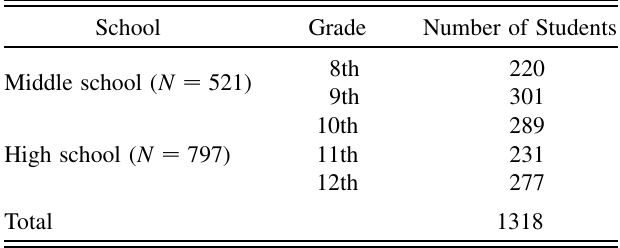
TABLE II. Participating student composition.